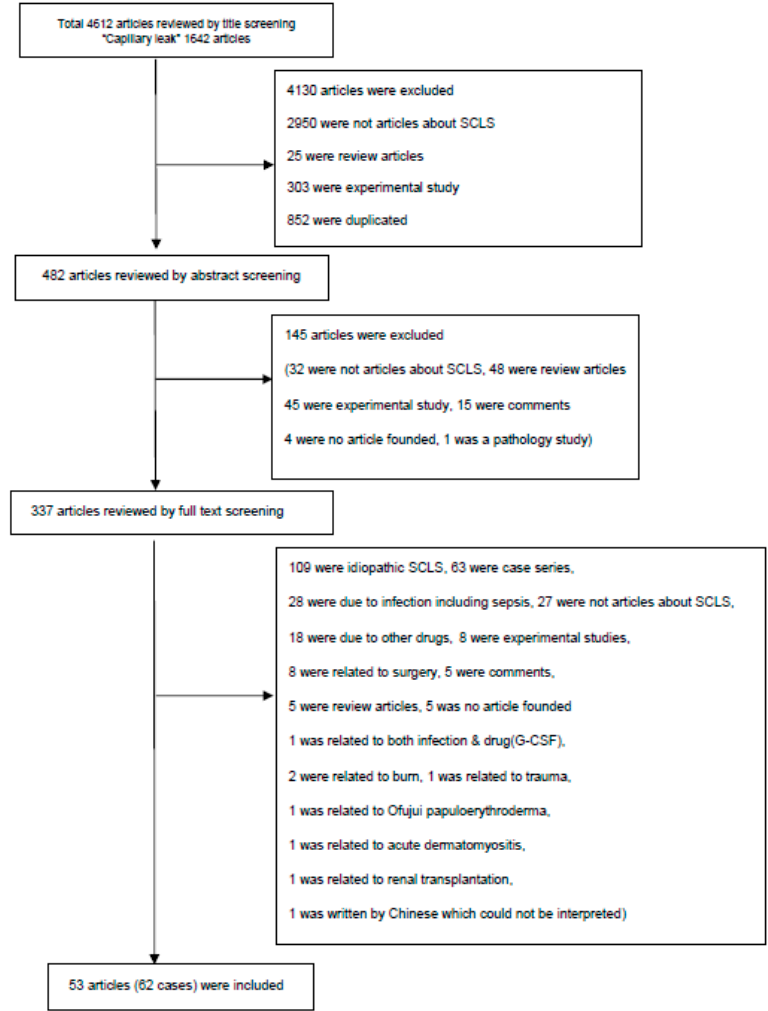
Figure 1. Flow chart of literature search.